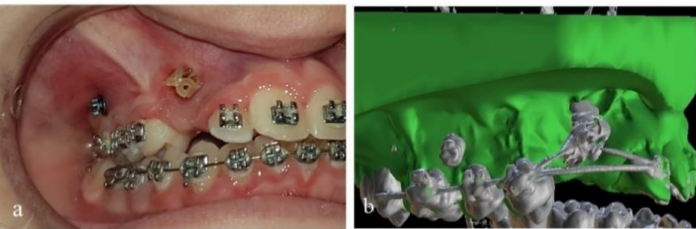
Figure 4. ( a ) Mini-implant in final place. ( b ) Digital model B (Initial .stl model and post-surgical DICOM files